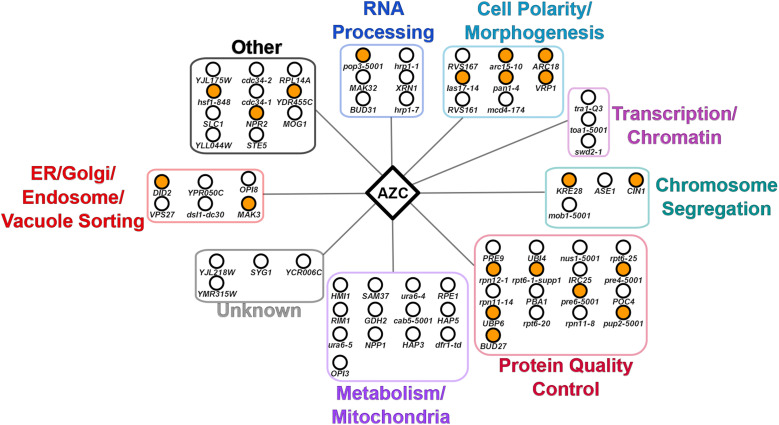
Negative genetic interactions between genes with negative chemical-genetic interactions with AZC and a tRNA that mistranslates serine at proline codons. Alleles that were identified as having negative chemical-genetic interactions with AZC were mated with a strain containing either a wild type tRNASer or tRNASerUGG, G26A which mistranslates serine at proline codons. Double mutants were selected using the SGA method described in Tong et al. (2001). Negative genetic interactions (orange) were determined by comparing double mutant fitness of the strains with tRNASer to the strains with tRNASerUGG, G26A in biological triplicate using SGAtools (Wagih et al. 2013) and a custom R script (supplemental file 1).